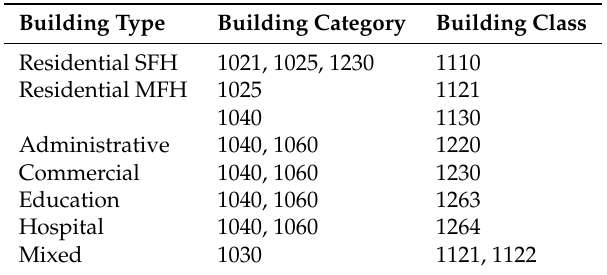
Table 2. Building types present in the model of the canton of